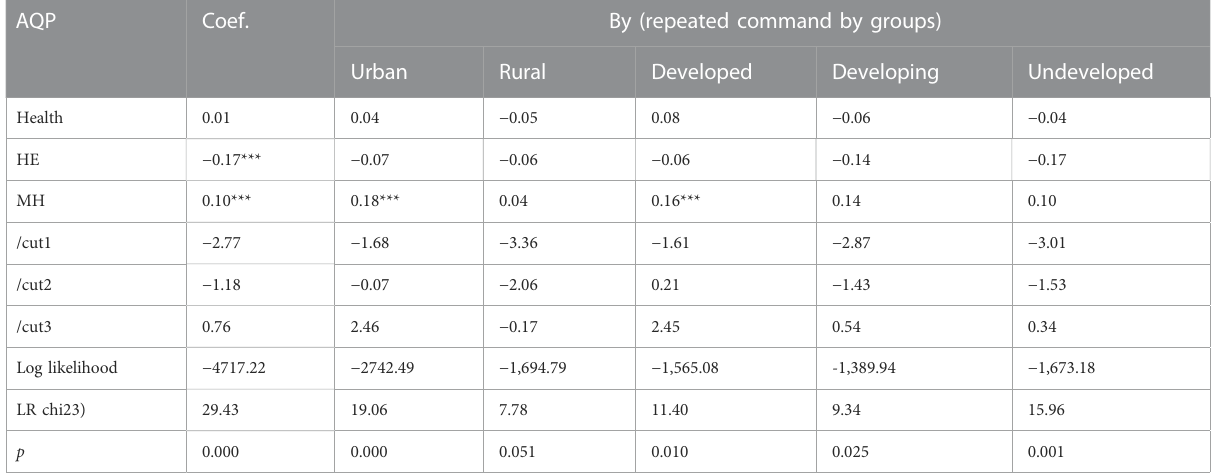
TABLE 5 Coef. of AQP and health condition. AQP Coef. By (repeated command by groups) Urban Rural Developed Developing